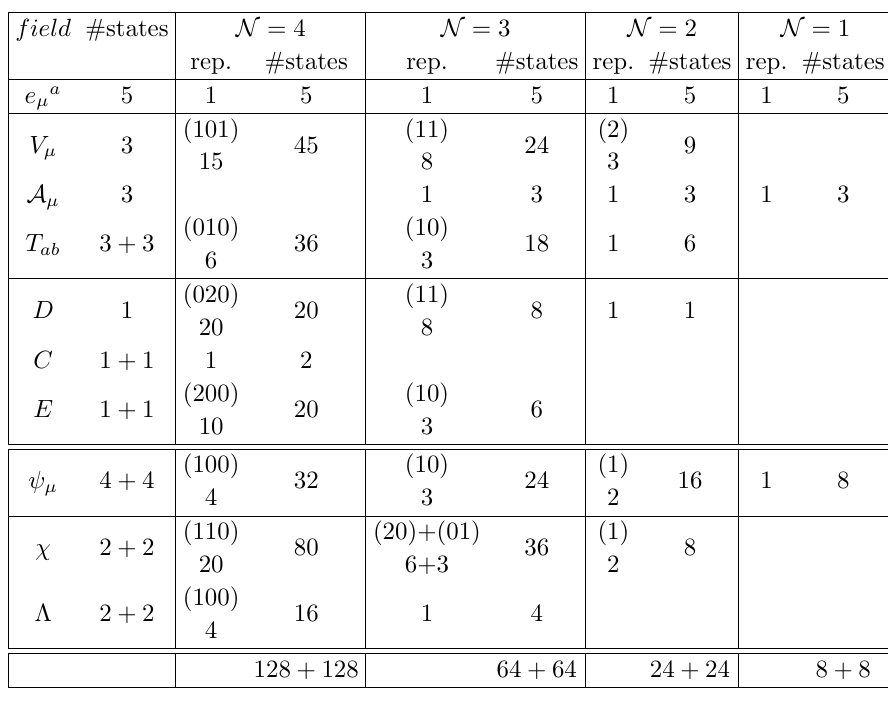
Table 5 . Weyl multiplets, ordered according to massive spin. The names of the (cid:12)eld contain only the spacetime indices, since the other indices depend on N . The second column gives the o(cid:11)- shell number of components as representation of the little group SU(2). Adding the representation content (counting double the (cid:12)elds reducible under SU(2)) agrees with the numbers in table 1. For the nontrivial representations, also the Dynkin labels are given, which corresponds to the Young Tableaux (the i -th Dynkin label is the number of columns with i vertical boxes). The (cid:12)elds that have two parts in the second column have also the conjugate representation in SU( N